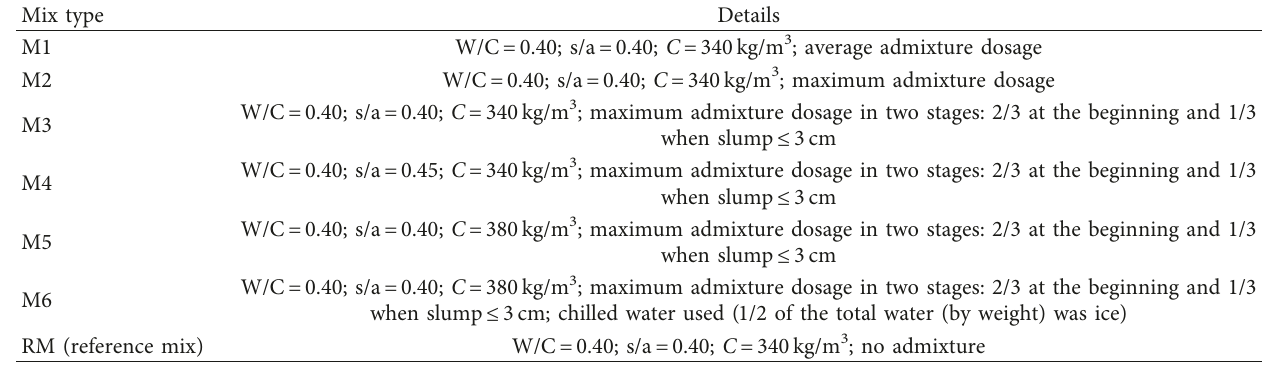
Table 4: Details of different types of concrete mixture.